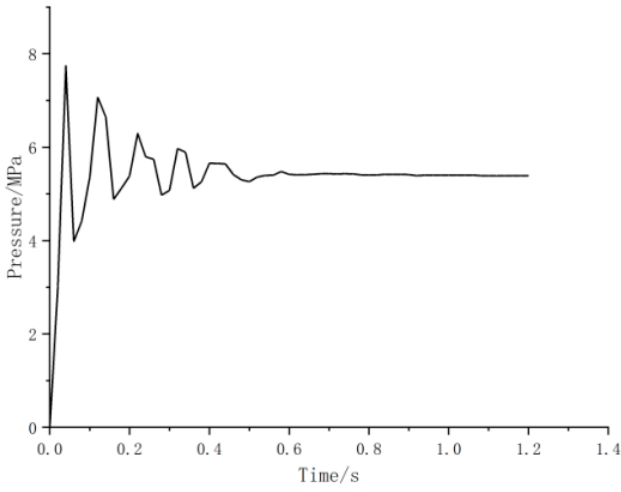
Figure 17. Pressure history curve for node A.